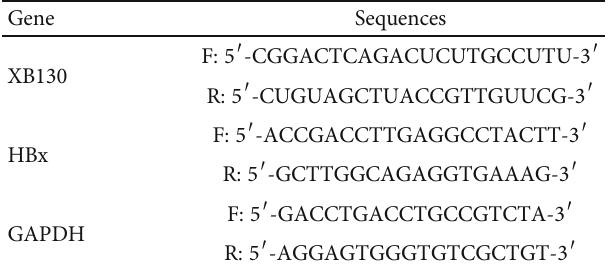
Table 2: Primer sequences for RT-qPCR.